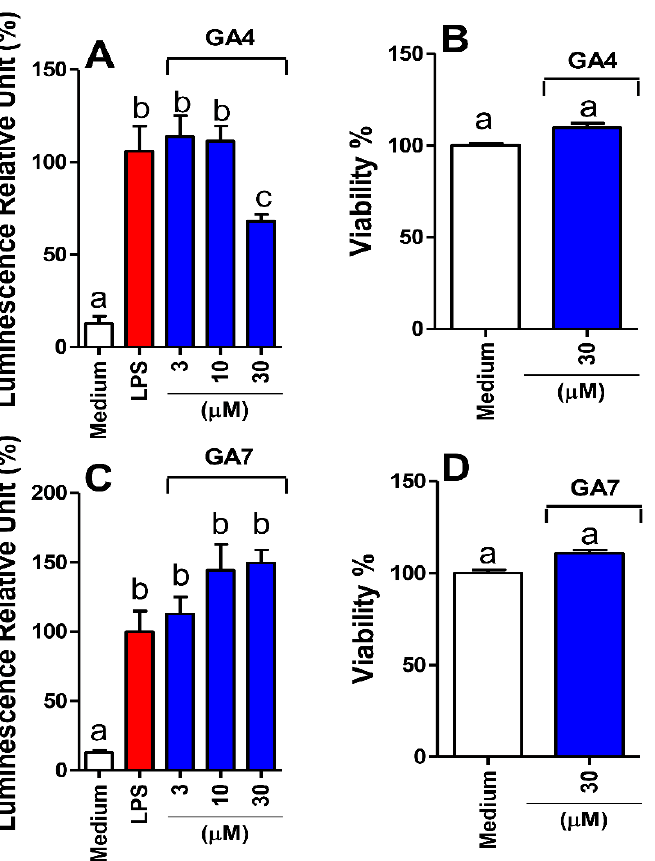
Figure 2. GA4 showed anti-NF- κ B activity by reducing NF- κ B activation without affecting macrophage viability, while GA7 was ineffective. RAW 264.7 macrophages were treated with GA4 and GA7 at 3, 10, and 30 µM and stimulated with LPS (10 ng/mL). NF- κ B activation was measured by the luminescence assay ( A , C ). Both GA4 and GA7 did not affect the viability of macrophages by the MTT method ( B , D ). Different letters indicate statistically significant differences determined by one-way ANOVA with Tukey’s post hoc test ( A , C ) or unpaired t -test ( B , D ) ( p < 0.05). A molecular docking assay was further carried out to confirm the binding capacity of GA4 to the p65 and p50 subunits of NF- к B. The five best results were selected, and are shown in Table 1. Table 1. Molecular docking assay with the plant hormone gibberellin A4 (GA4) and the p65 and p50 subunits of NF- к B.